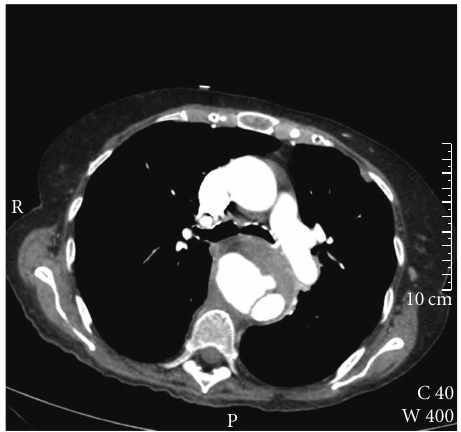
Figure 2: CT scan of the thoracic aorta demonstrating a mycotic aneurysm in the descending thoracic aorta.